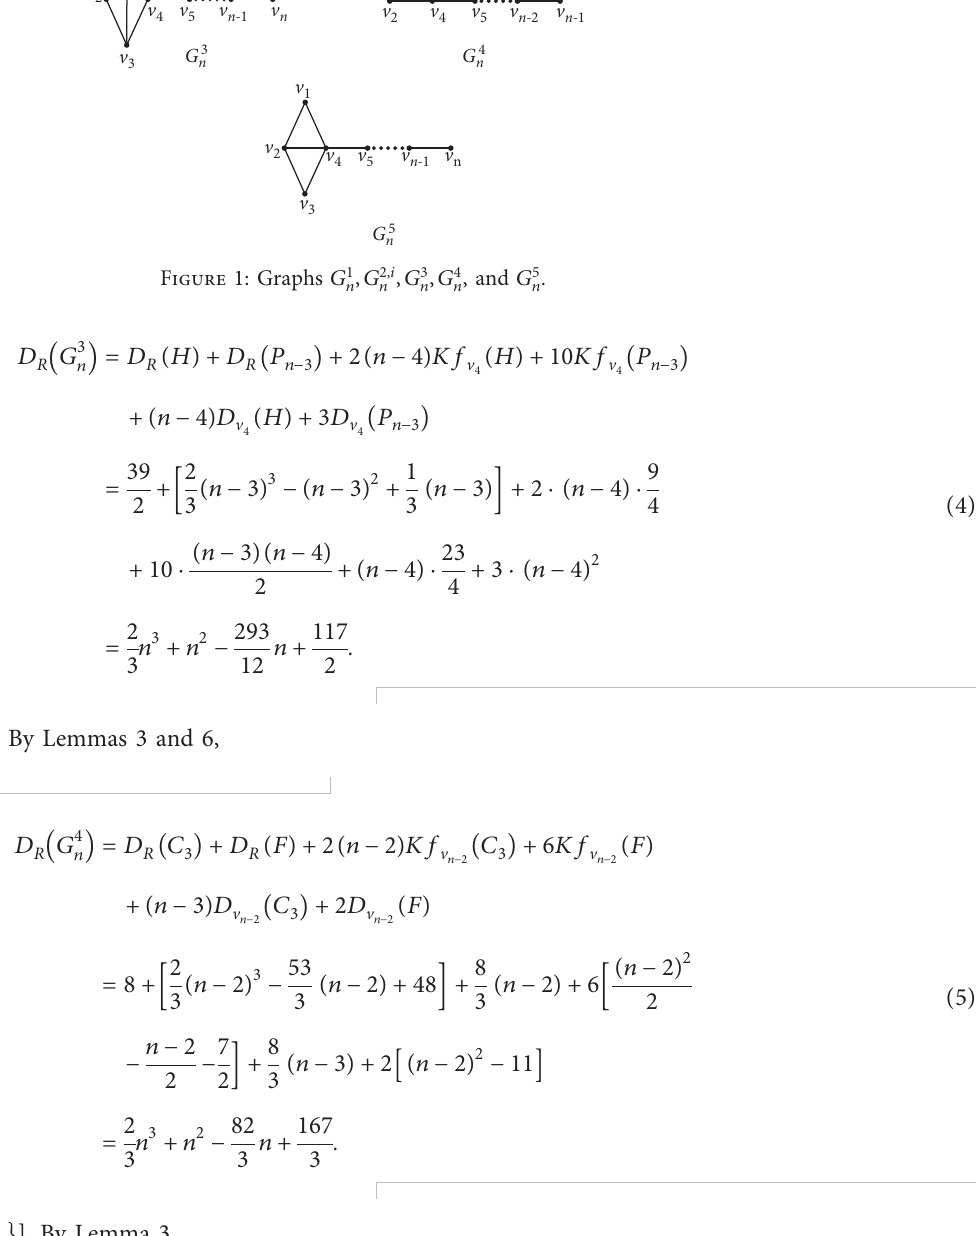
Figure 1: Graphs G 1